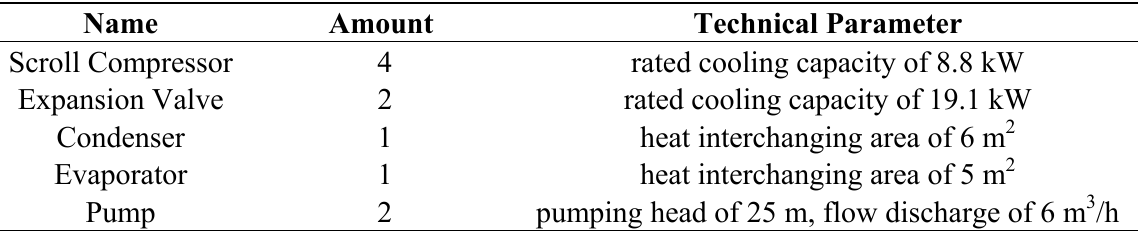
Table 2. Technical specifications of the major